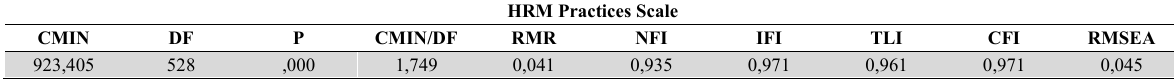
CFA Results of HRM Scale